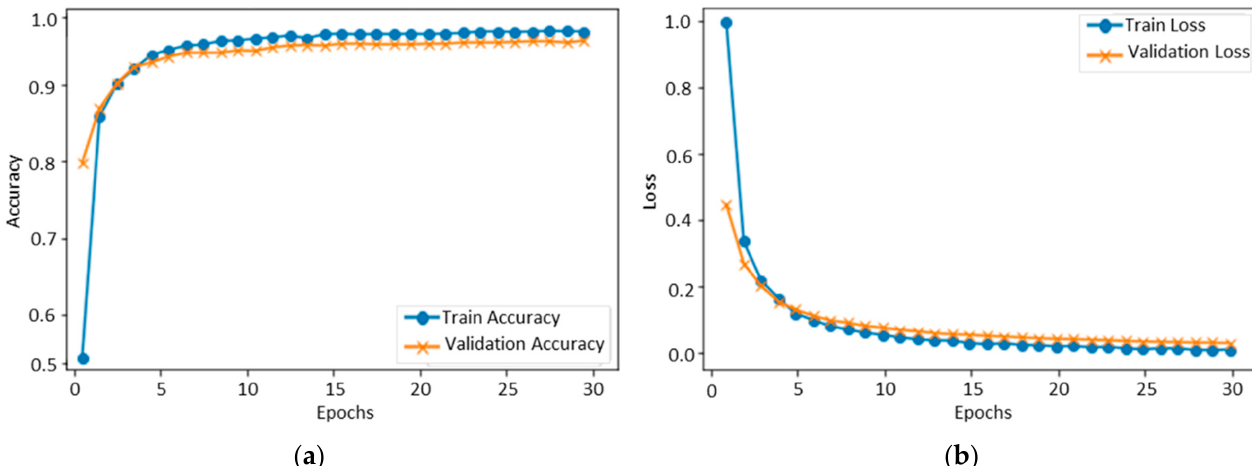
Figure 7. Training and validation of the proposed model over the KDEF dataset: ( a ) accuracy and